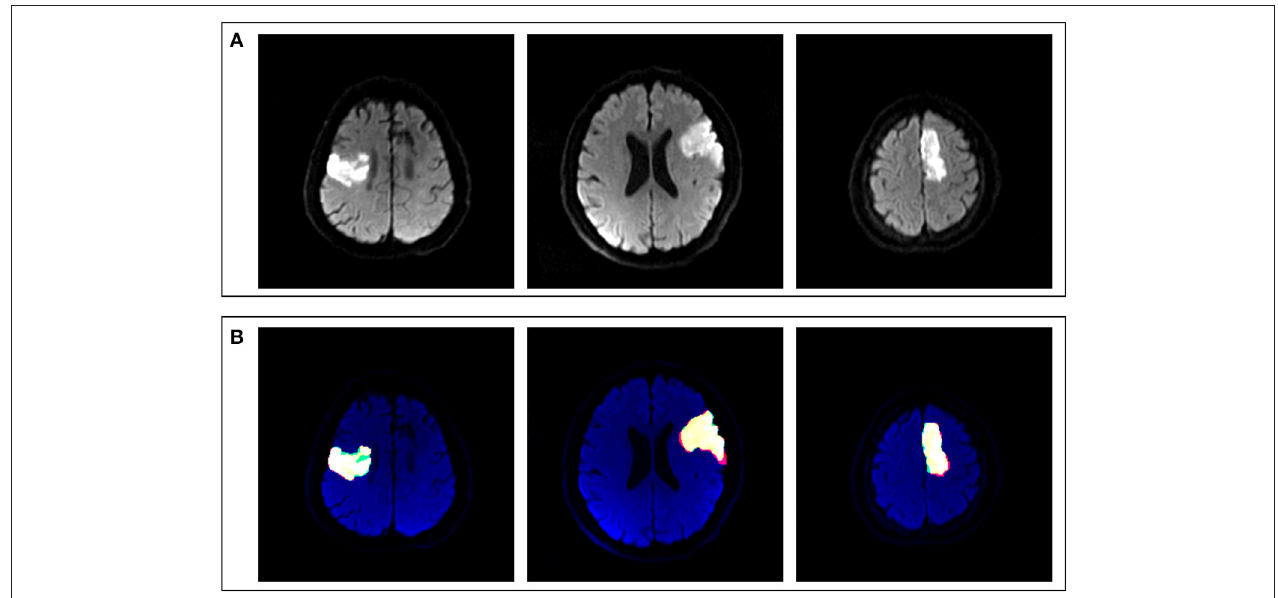
FIGURE 3 | Comparison between artificial intelligence (AI)-based segmentation and manual segmentation in three cases of ASACNLII. (A) DWI images. (B) Segmentation results, in which red represents manual labeling results, green the AI output results, and yellow the consistent areas.